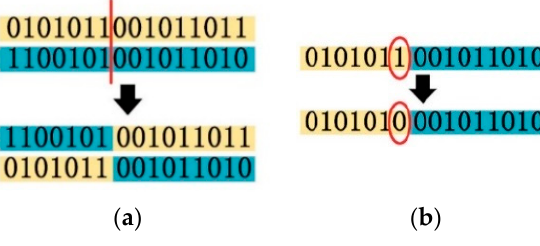
Figure 2. ( a ) Crossover process; ( b ) mutation process.